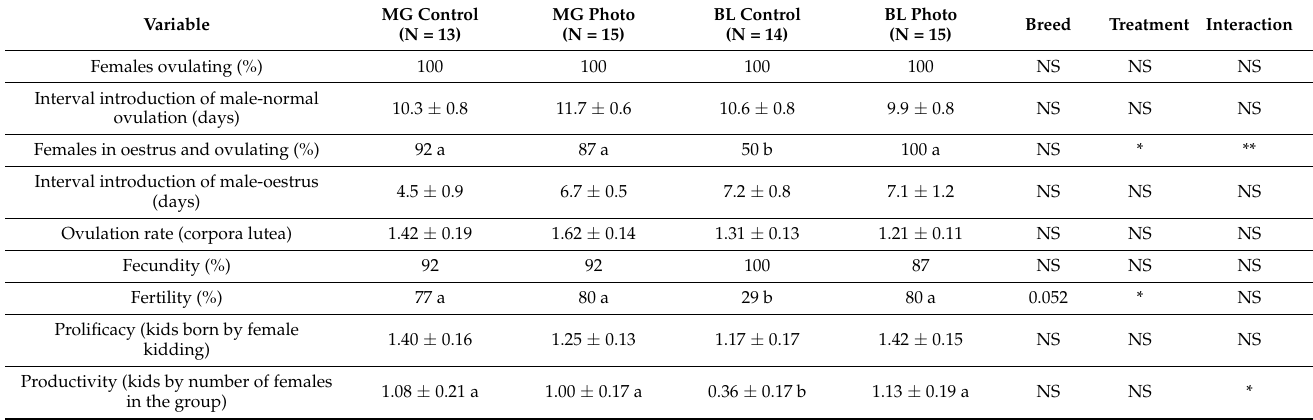
Table 1. Reproductive response of does exposed to Murciano–Granadina (MG) or Blanca Andaluza (BL) bucks submitted to an artificial photoperiod to stimulate their reproductive activity (Photo) or a natural photoperiod